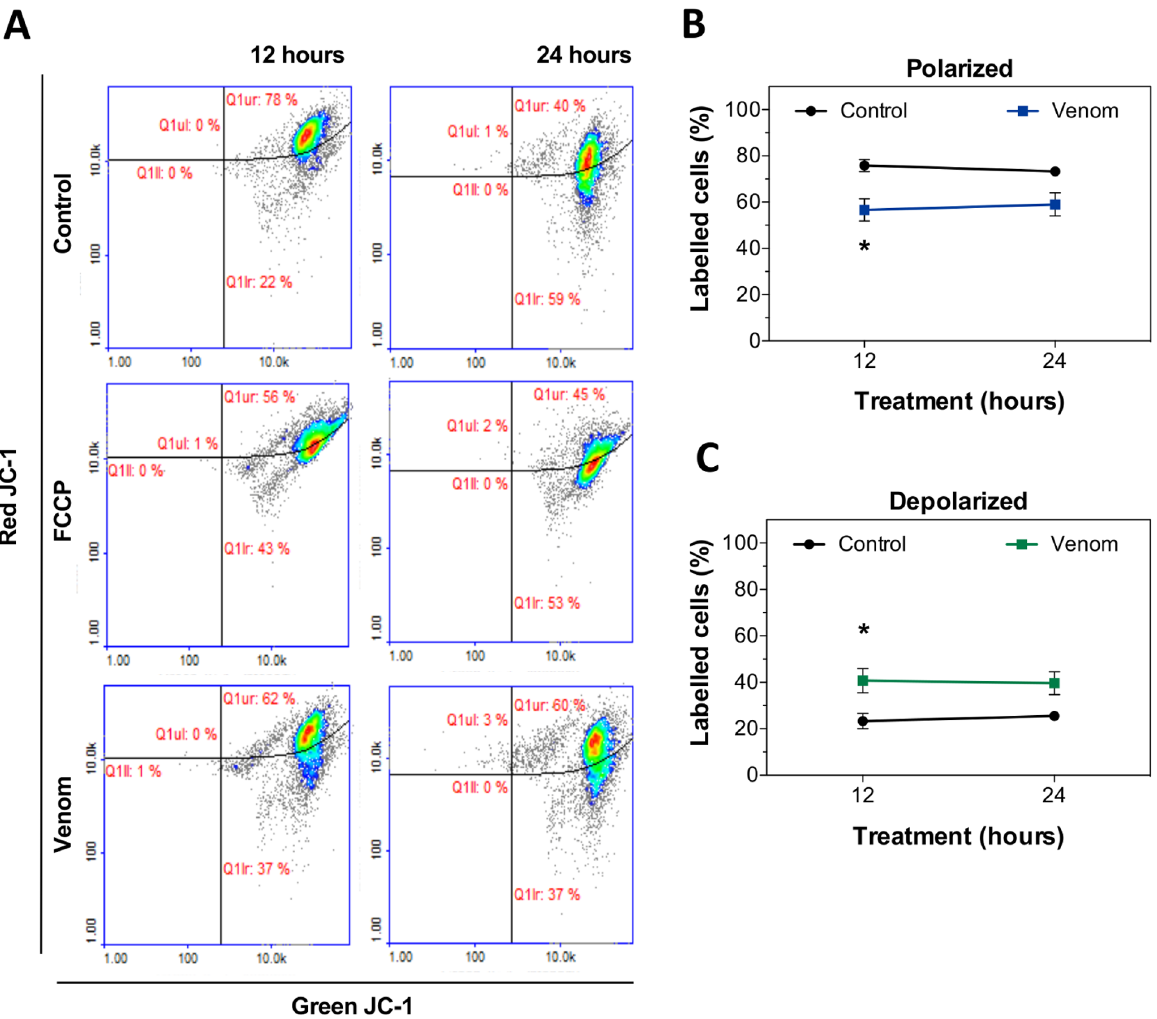
Fig 4. Mitochondrial membrane depolarization triggered by L . m . muta venom in keratinocytes. (A) Representative cytometry plots for keratinocytes mitochondrial membrane potential after treatment with FCCP 50 μ M for 15 minutes, 2x EC 50 of L . m . muta venom for 12 and 24 hours, or left untreated. Cells were stained with the dye JC-1. Graphs showing the percentages of normal (polarized) (B) and damage (depolarized) cells (C) . Data are represented as means ± SEM (n = 3, data were collected from three independent experiments). Venom-treated groups were compared to their control using two-way ANOVA ( (cid:3) p <